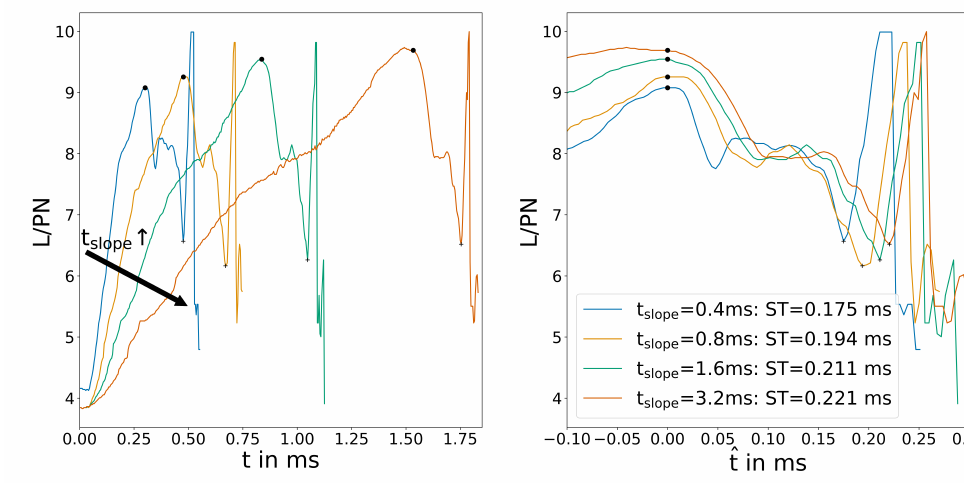
Figure 8. Position of the reattachment point determined by wall shear stress for the variation of t slope